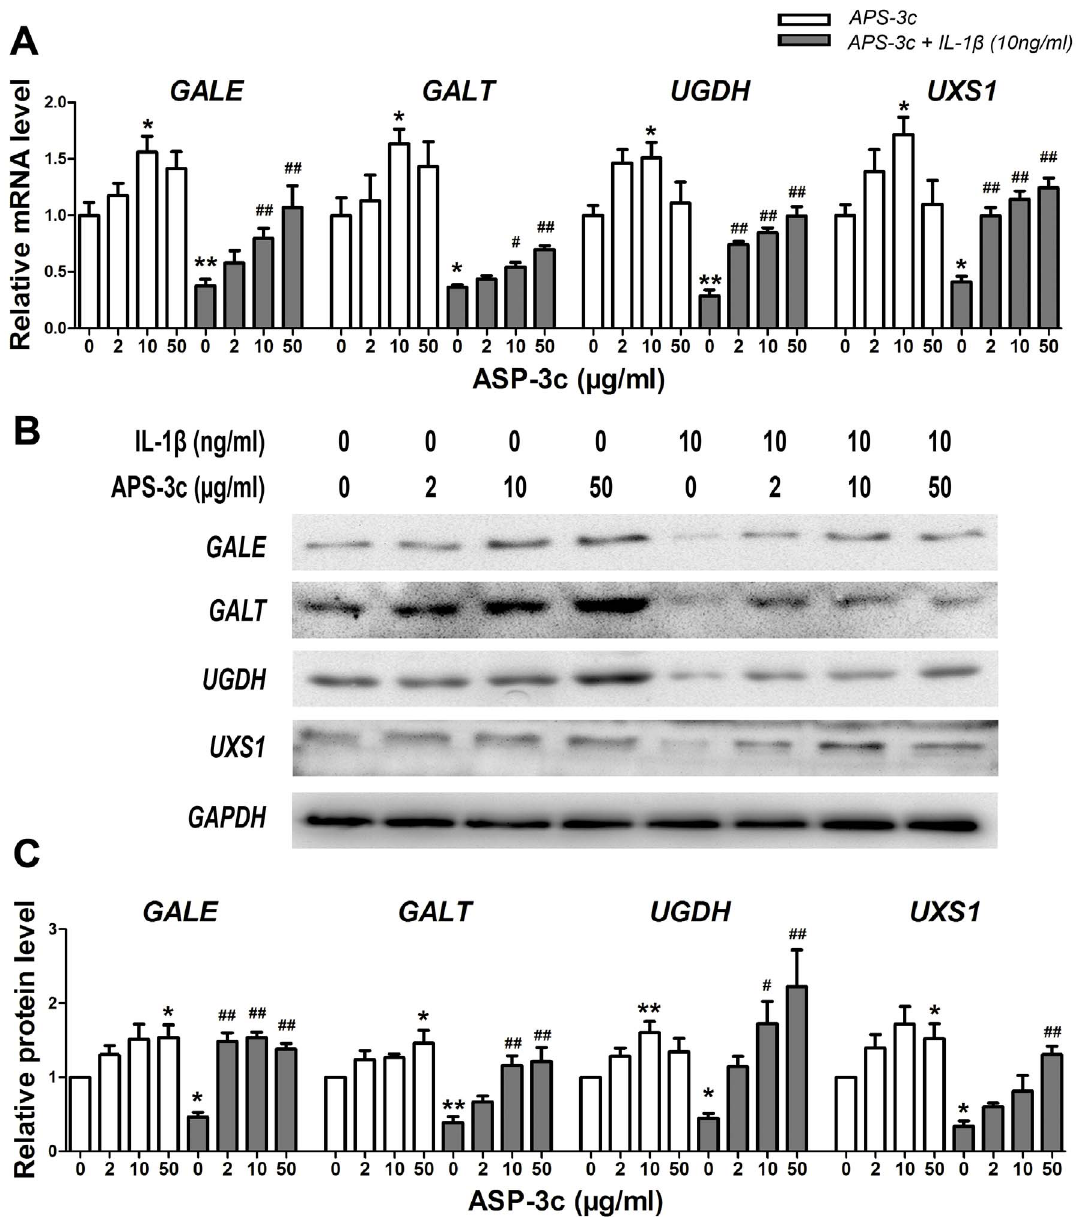
Figure 2. APS-3c modulated gene expression of UDP-sugar synthases invitro . A, The mRNA levels of UDP-galactose-4-epimerase ( GALE ), galactose-1-phosphate uridylyltransferase ( GALT ), UDP-glucose 6-dehydrogenase ( UGDH ), and UDP-xyl synthase 1 ( UXS1 ) were detected in chondrocytes treated with 2,10 and 50 m g/ml ASP-3c, or pre-treated with 10 ng/ml interleukin 1 beta (IL-1 b ) for 30 min and consequently co-treated with IL-1 b and ASP-3c for another 48 h using real time quantitative PCR assay. B and C, The protein level of GALE, GALT, UGDH and UXS1 was also detected using Western blotting assay. Then, the mean optical density of each lane was analyzed. Values were presented as mean 6 SEM from three independent experiments. * P , 0.05, ** P , 0.01 versus control group; # P , 0.05, ## P , 0.01 versus IL-1 b